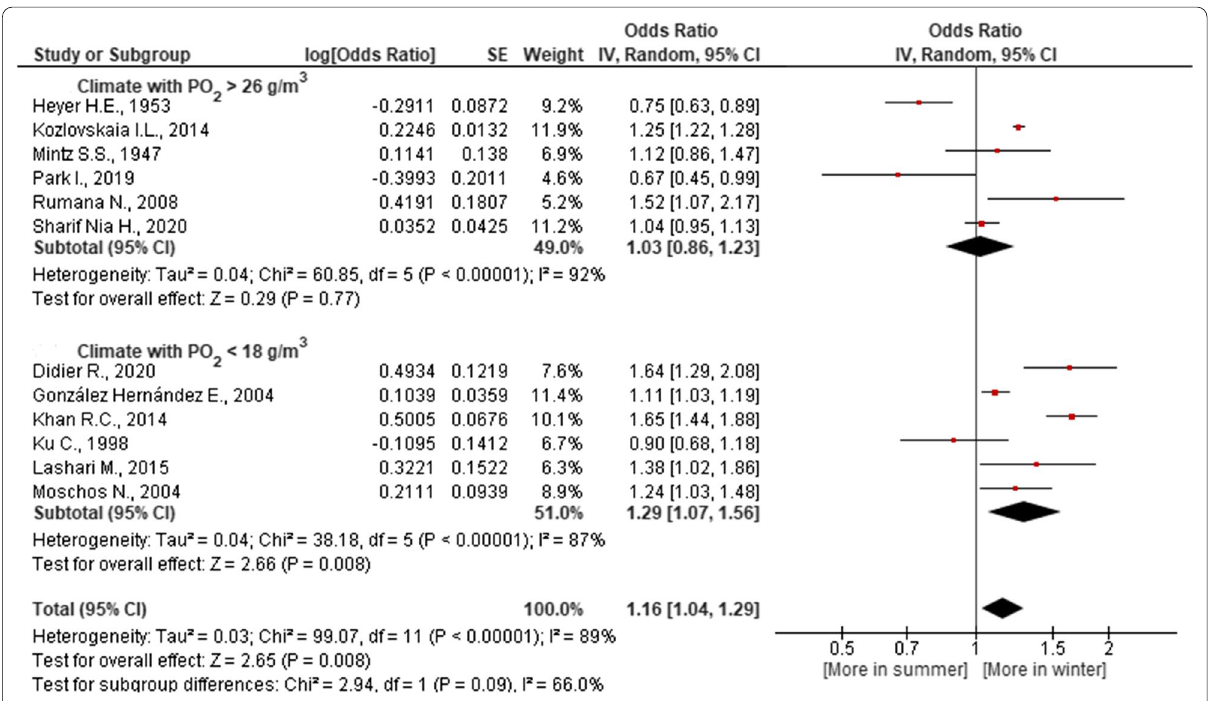
Fig. 5 Association of seasonal risk of myocardial infarction with partial density of oxygen in